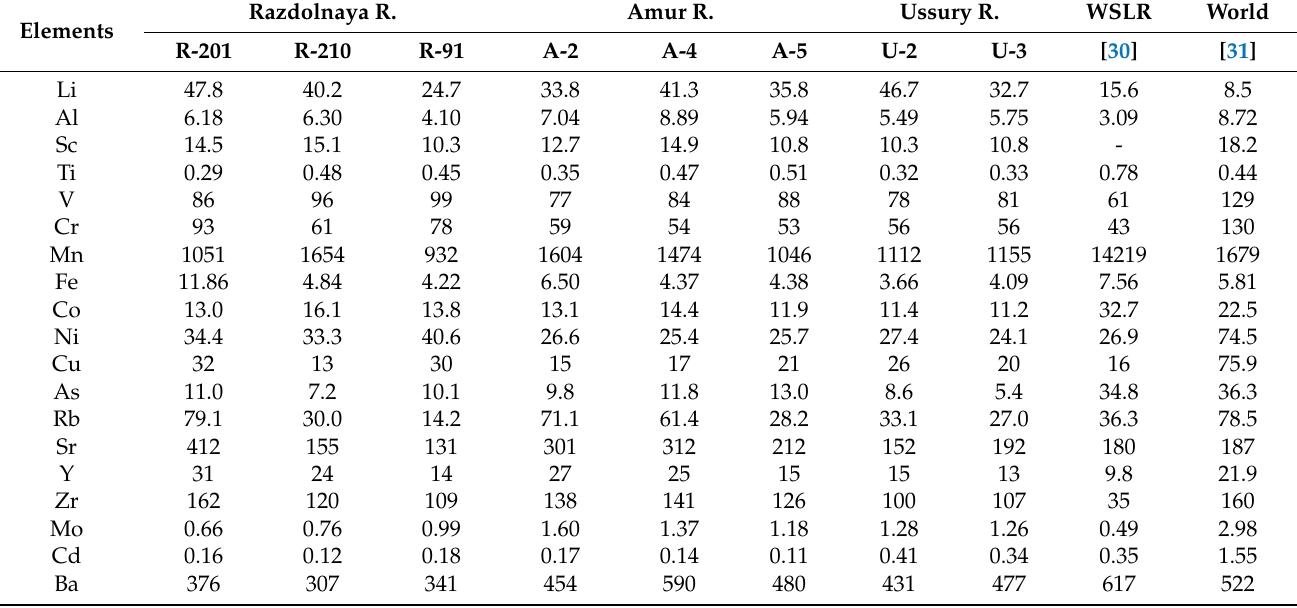
Table 3. Concentration 1 of trace elements in the suspended solids of the boreal rivers of the Russian Far